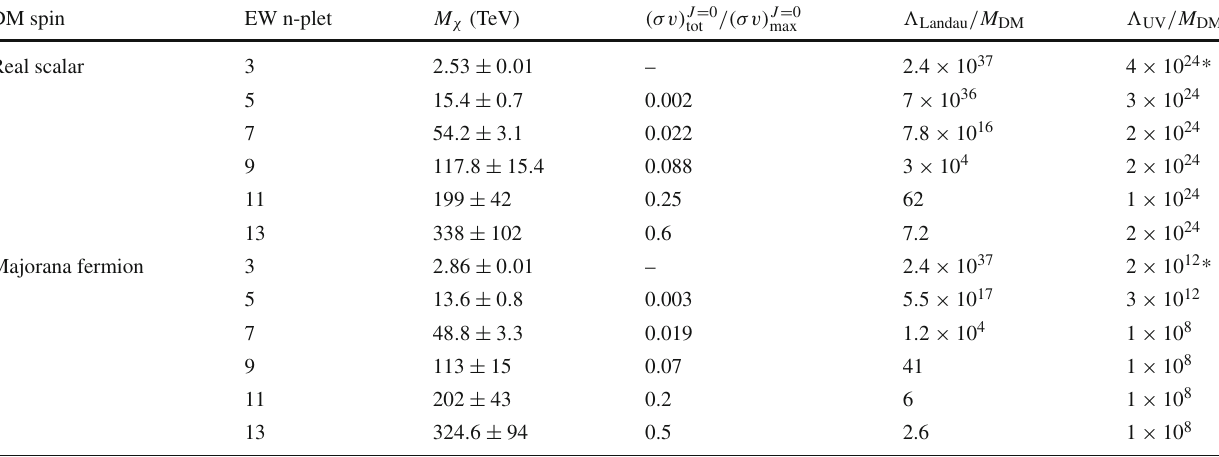
Table 1 Freeze-out mass predictions for WIMP DM in real EW mul- stability of both scalar and fermionic DM can always be enforced by requiring a Z 2 symmetry in the DM sector to forbid DM decays. This tiplets with Y = 0. The annihilation cross-section includes both the contribution of SE and BSF. We provide a measure of how close the symmetry forbids the scalar and fermionic 3-plets decay at renormaliz- DM annihilation cross-section is to the unitarity bound for s -wave anni- able level as indicated by the *. The value of the UV cut-off (cid:8) UV gives v . Approaching the unitarity bound, the hilation (σv) J = 0 max = 4 π/ M 2 an idea of the required quality for this symmetry to make DM stable DM and avoid stringent bounds on decaying DM ( τ DM > 10 28 s) [26]: a new error on the WIMP mass grows proportionally to the enhancement of the next-to-leading order (NLO) contributions estimated in Eq. (23). physics scale lower than (cid:8) UV would require a Z 2 to explain DM stabil- We derive the scale where EW gauge coupling will develop a Landau ity, while a cut-off higher than (cid:8) UV would make DM stability pole by integrating-in the WIMP multiplet at its freeze-out mass. The